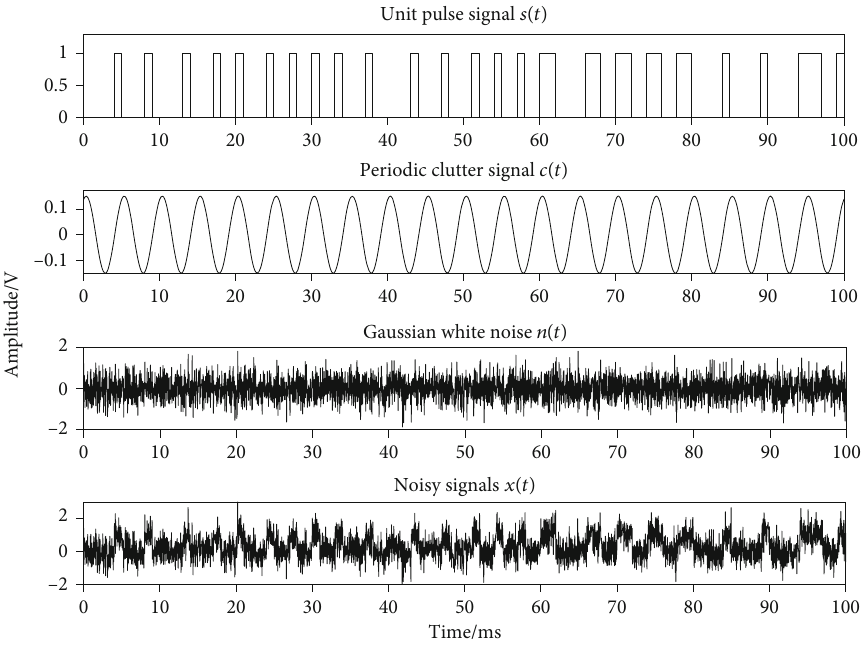
Figure 9: Noisy BTT impulse